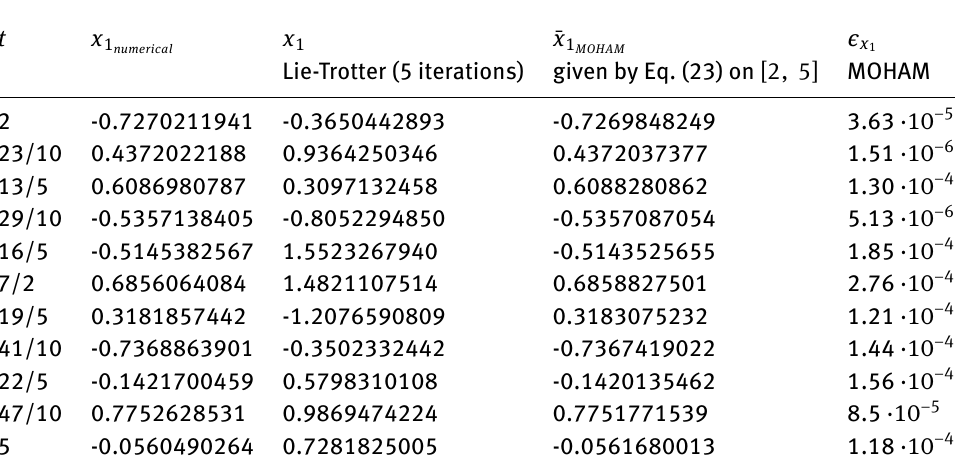
− ¯ x 1 | MOHAM numerical